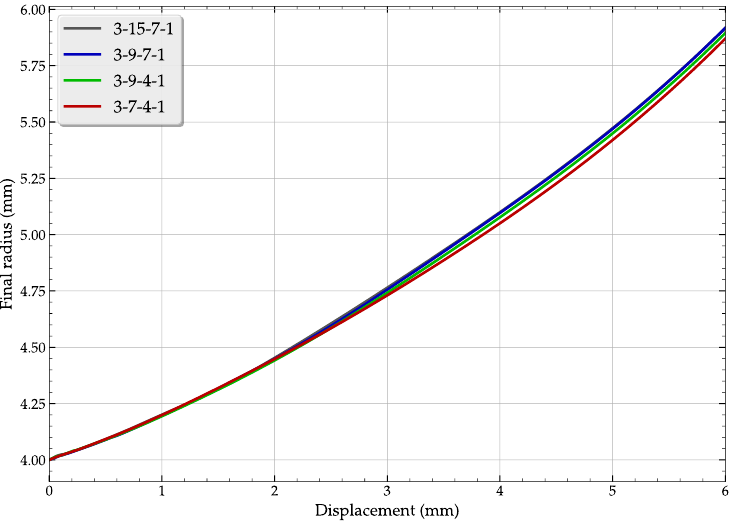
Figure 10. Evolution of the external radius r of the specimen during the compression process using the four ANN flow laws (only the 3-15-7-1 model differs).